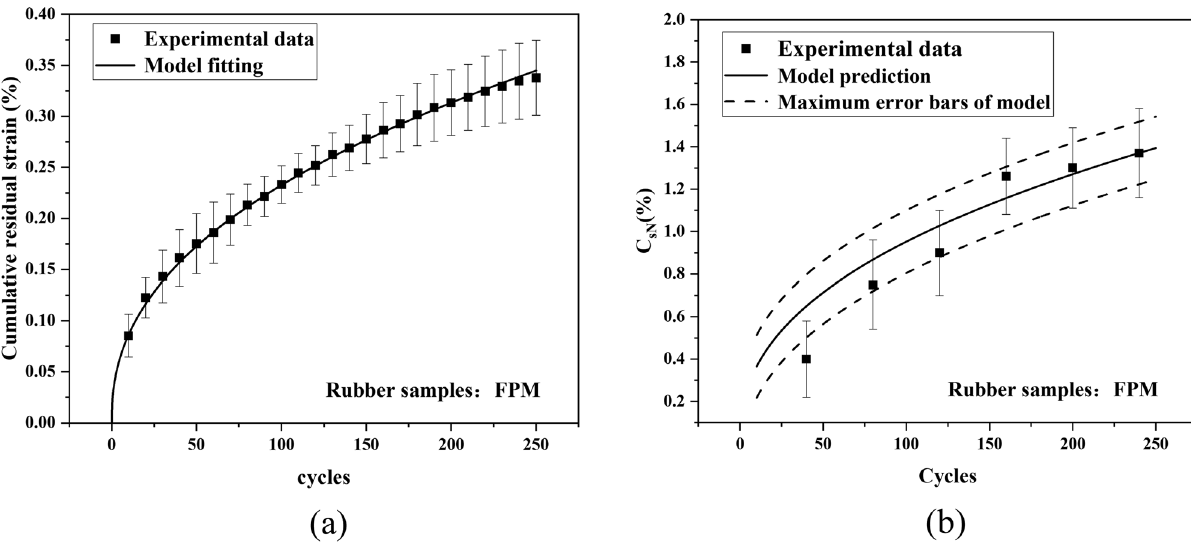
Figure 15: Accumulated residual strain ( a ) and cycle - induced compression set prediction ( b ) of FPM